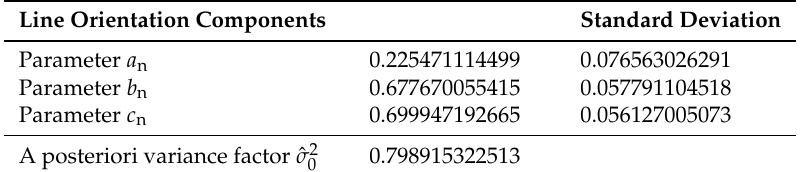
Table 5. Iterative WTLS solution from Section